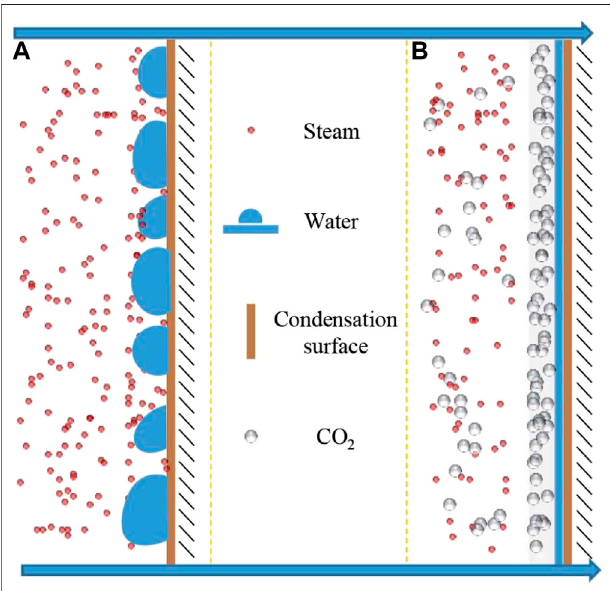
FIGURE7| Schematicdiagramofthesteam condensationheattransfer mechanism with or without CO 2 . Adapted from (Wang et al.,